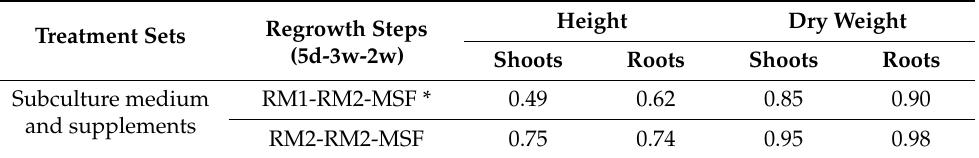
Table 1. The correlation coefficient between height and dry weight of donor plantlets subcultured once in the last cycle before cryopreservation (nine variants) and regeneration of subsequently cryopreserved shoot tips.